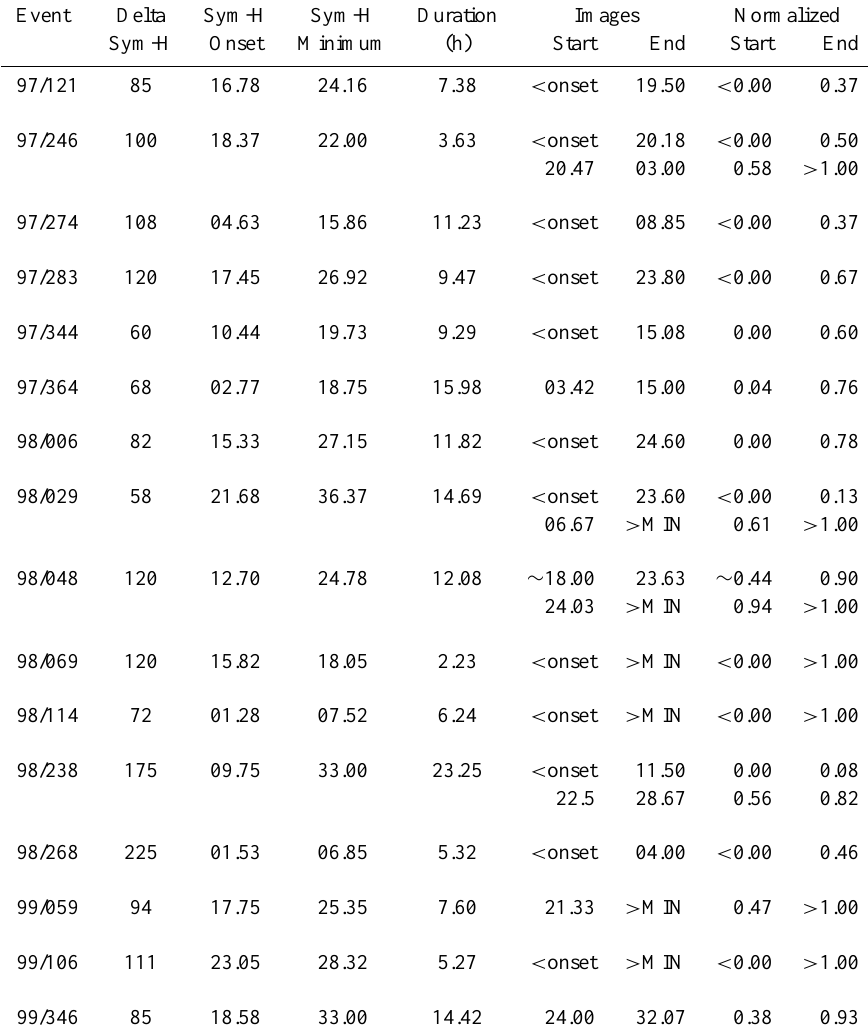
Table 1. Coverage by global auroral images of main phase development for 16 storms. Times are in decimal hours. Event Delta Sym-H